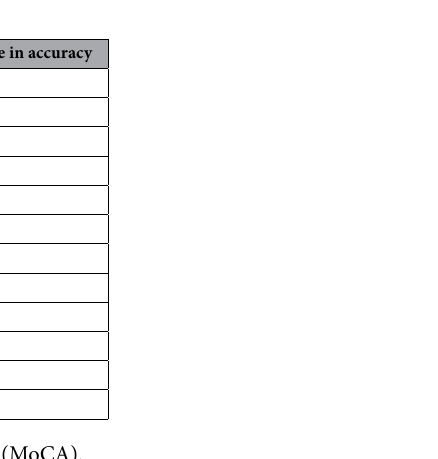
Table 5. Ranking of feature importance in the RF model